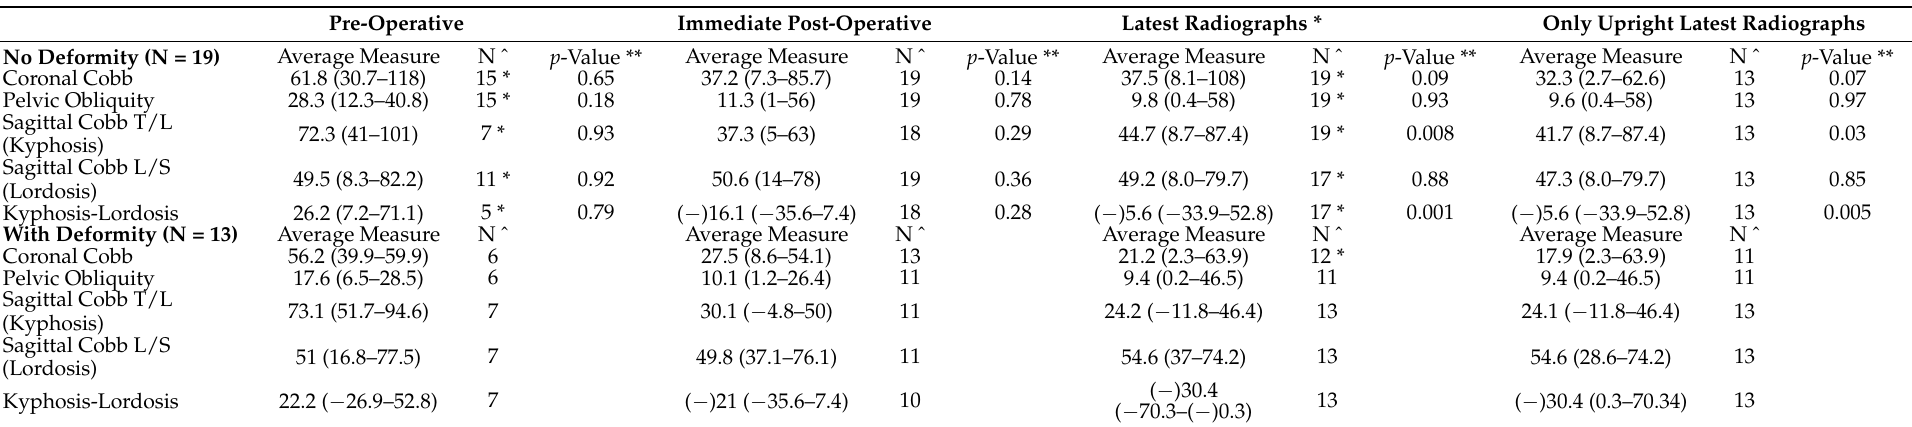
Table 6. Analysis of spinal parameters at each time point, comparing those with and without spinal